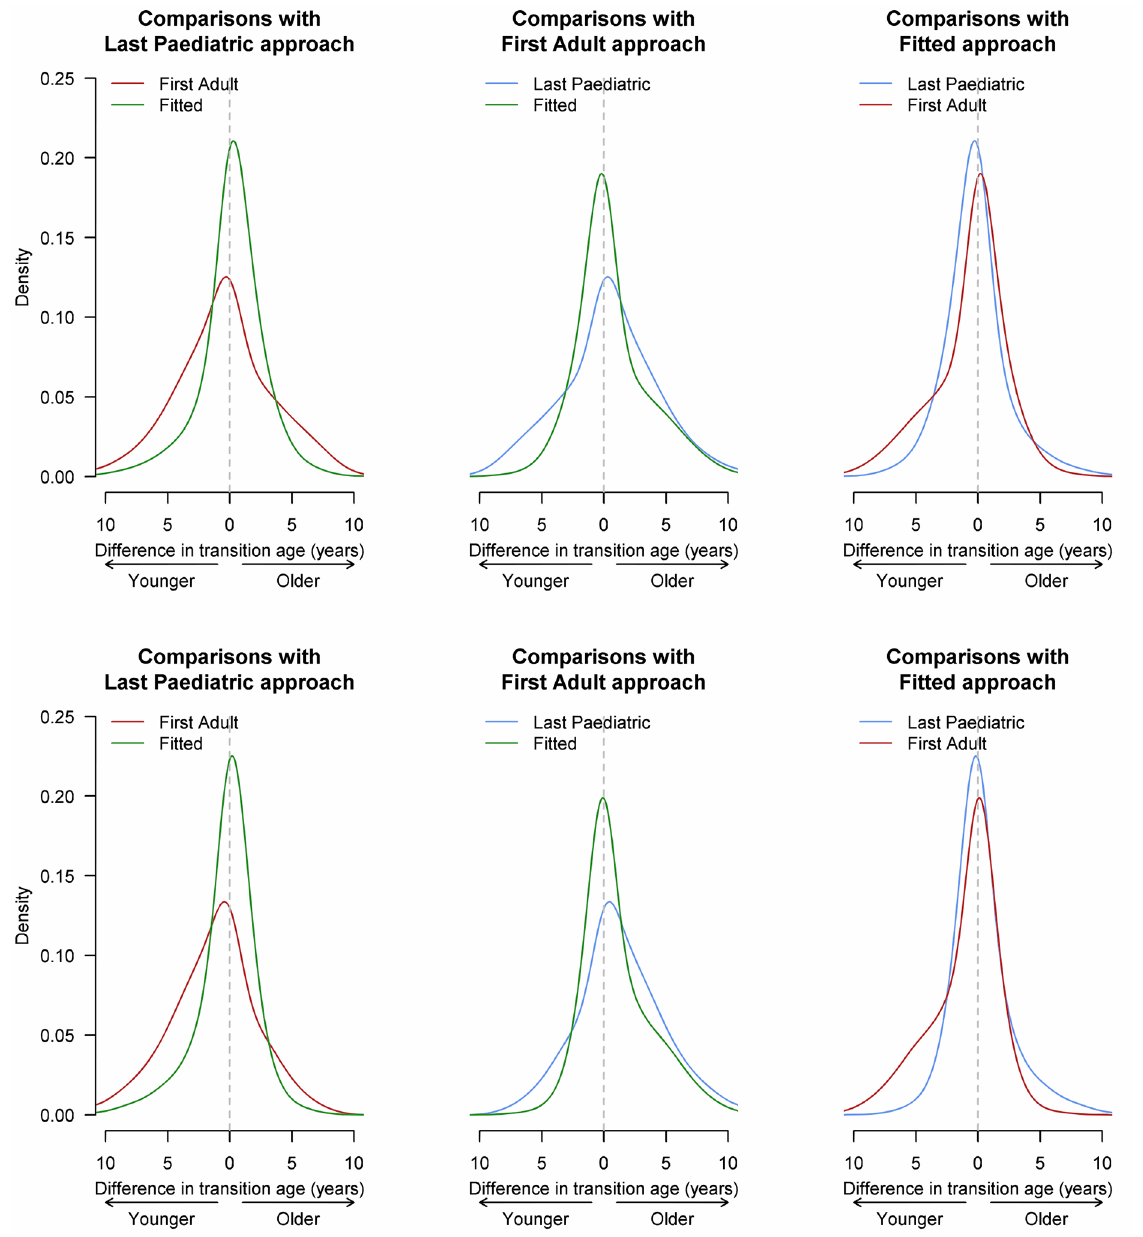
Top: whole cohort; Bottom: Frequent Care